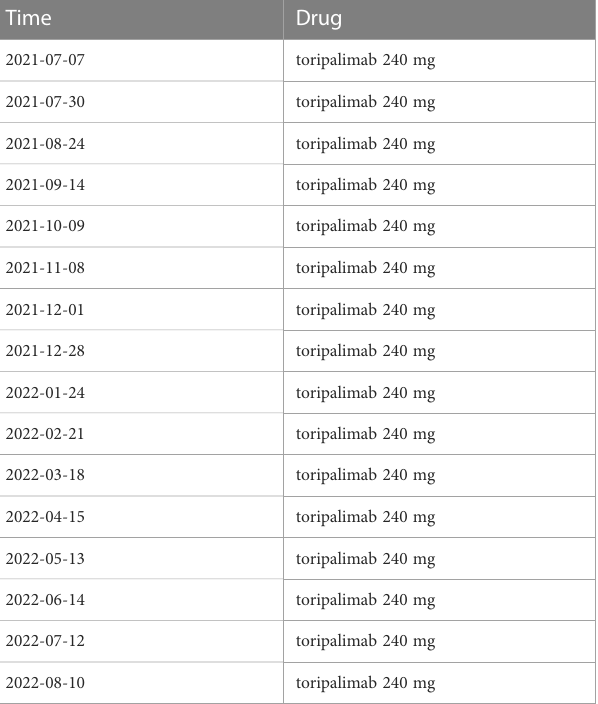
TABLE 1 The duration of medication administration.